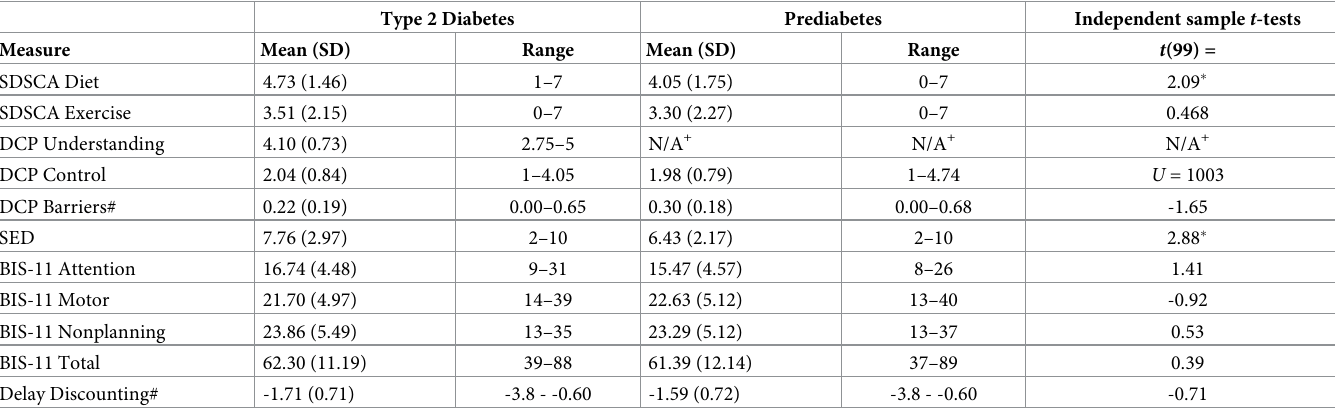
Table 2. Means (SD) and ranges for each measure by